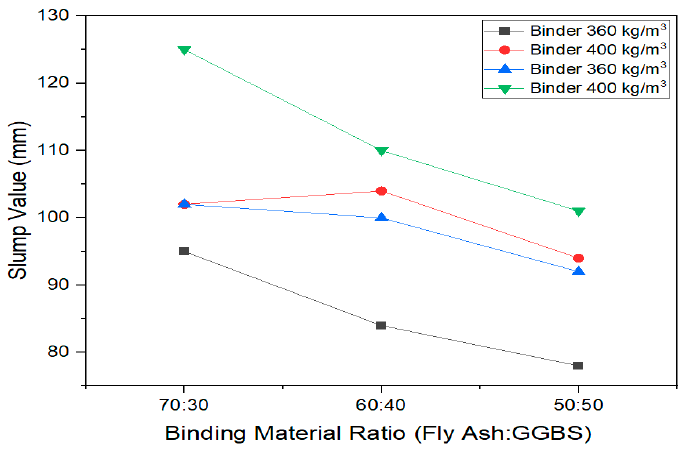
Figure 9. Workability of GPC.